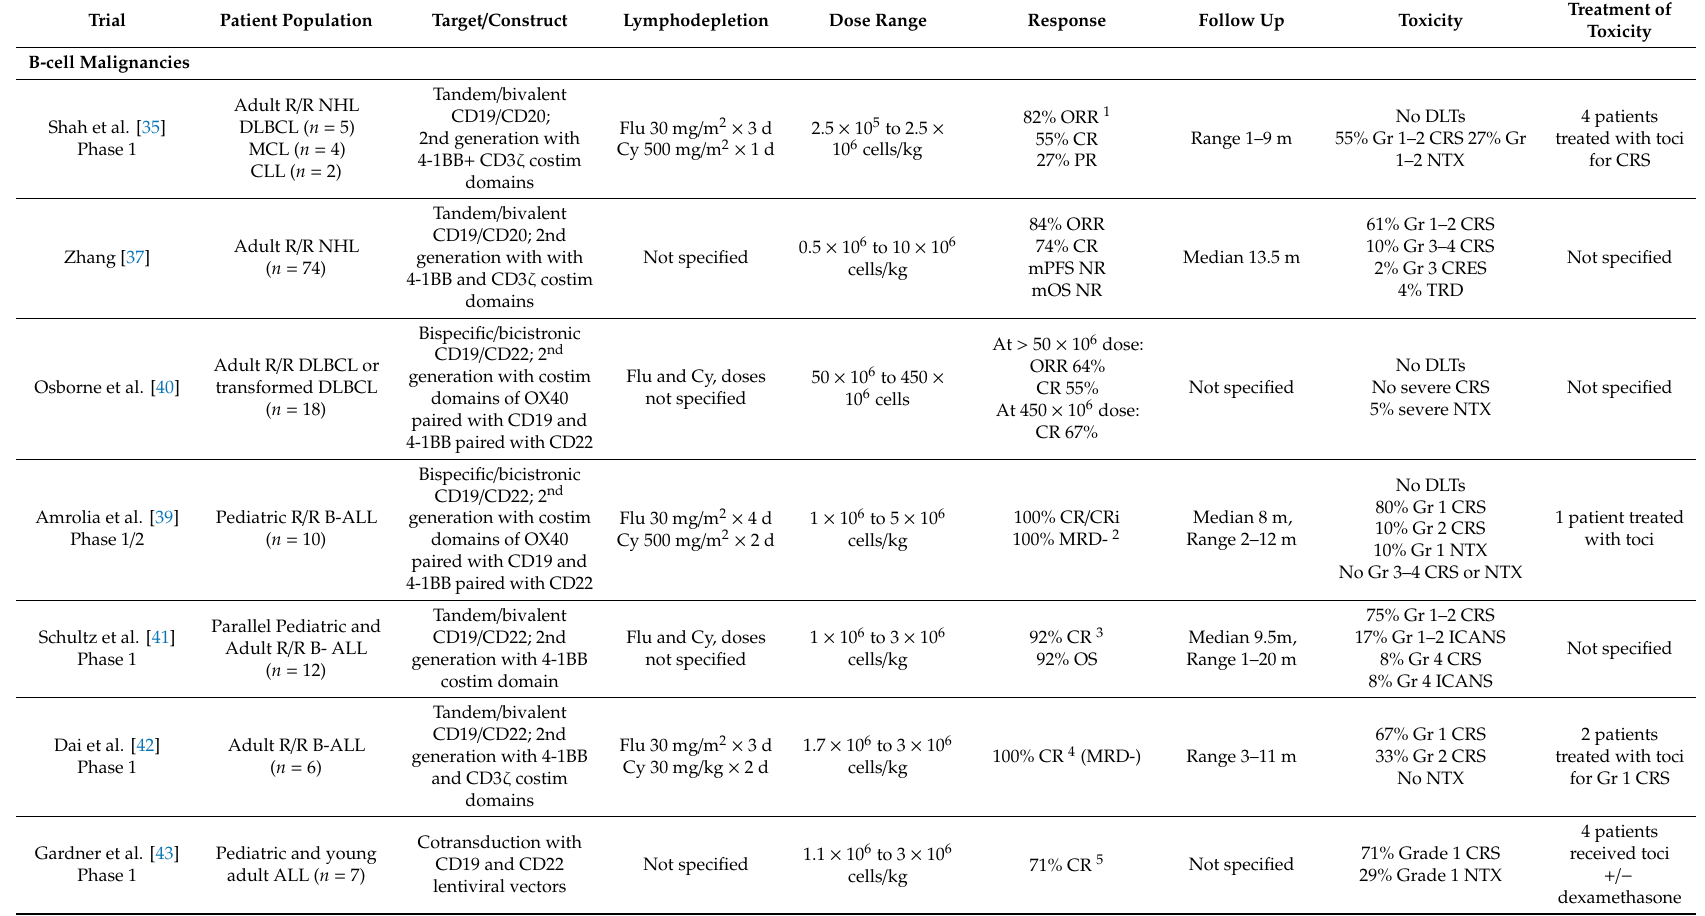
Table 1. Bispecific CAR T cell therapies in relapsed / refractory B-cell malignancies and multiple